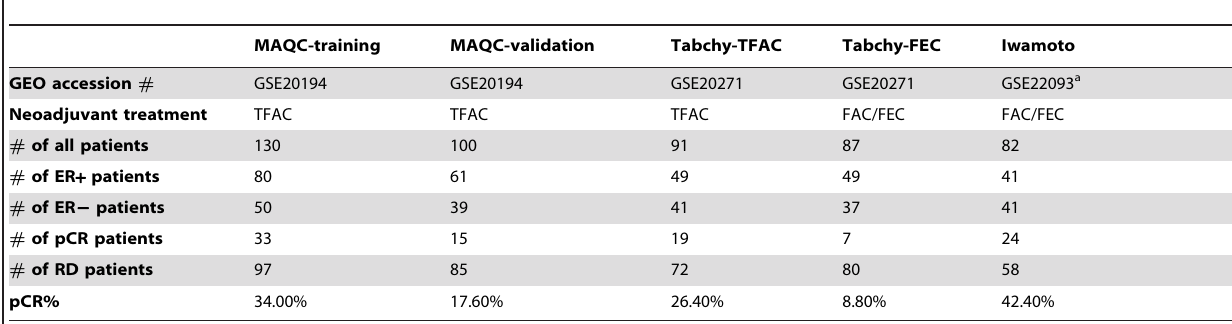
Table 2. Summary information for the gene expression and clinical outcome test sets for five clinical trials in the GEO